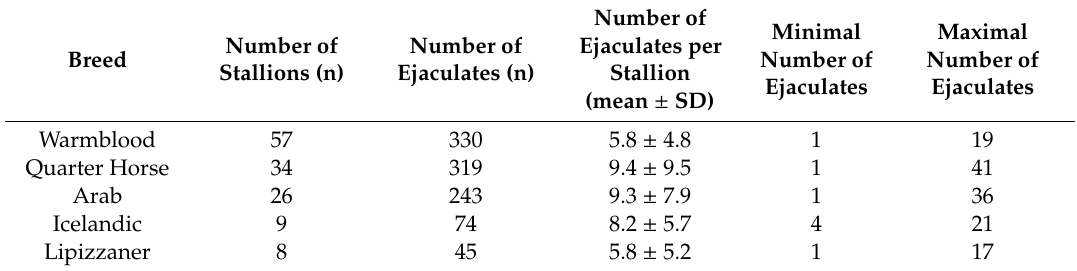
Table 1. Horse breeds included into the study with number of stallions and number of cryopreserved ejaculates per